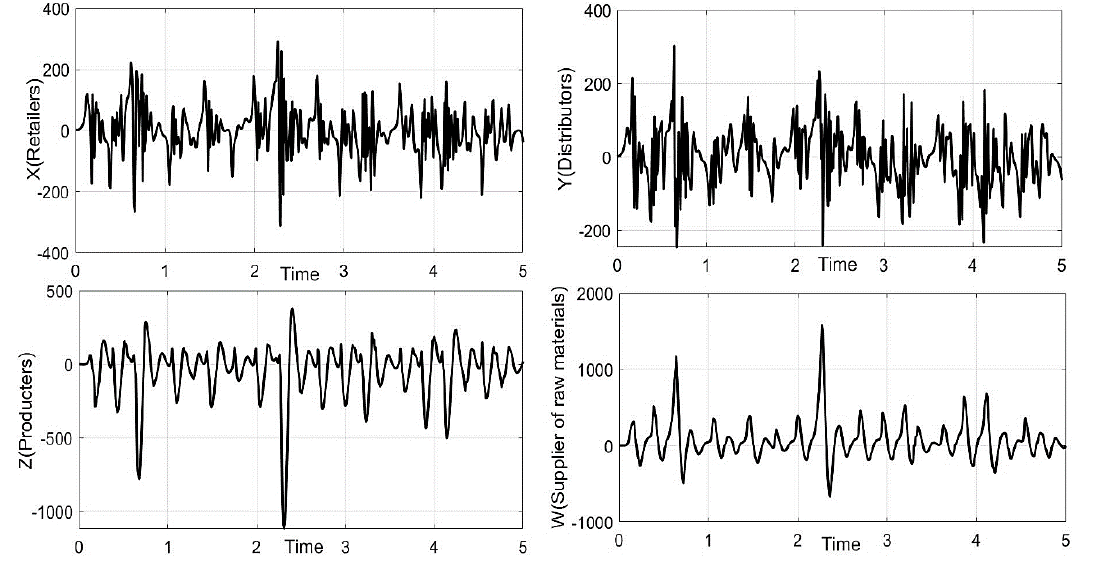
Fig. 2. Hyperchaotic supply chain behavior.